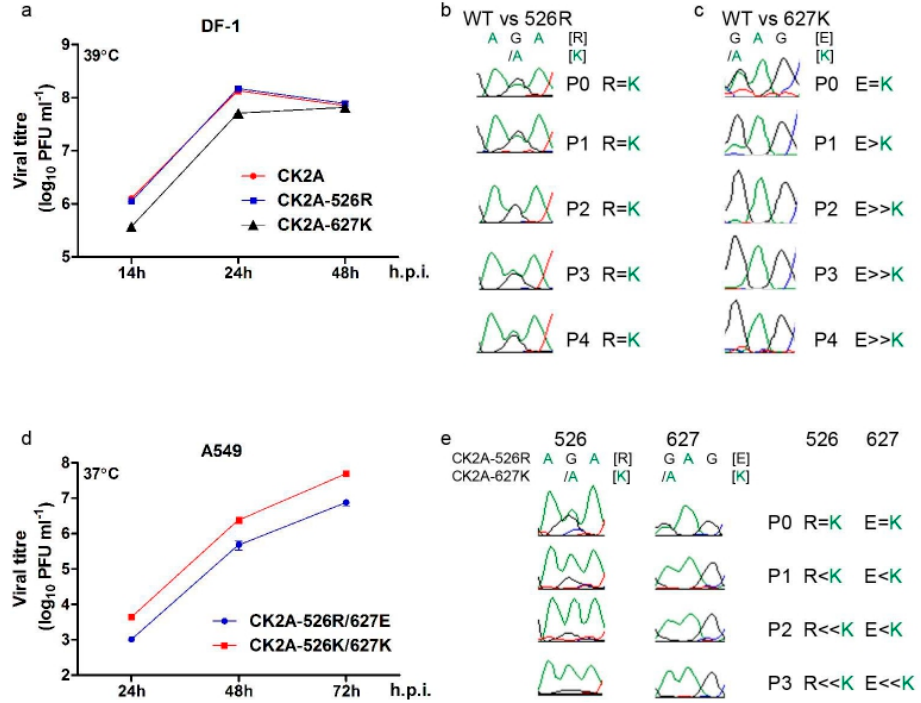
Figure 7. Comparison of effects of PB2 526R and 627K on Indonesian H5N1 virus replication. ( A ) Growth kinetics of reverse genetic versions of CK2A virus containing PB2 526R or 627K in avian cells. DF-1 cells were infected separately with CK2A, CK2A-526R or CK2A-627K RG virus and cultured at 39 °C. Culture supernatant was collected at the indicated time points and virus titrated by plaque